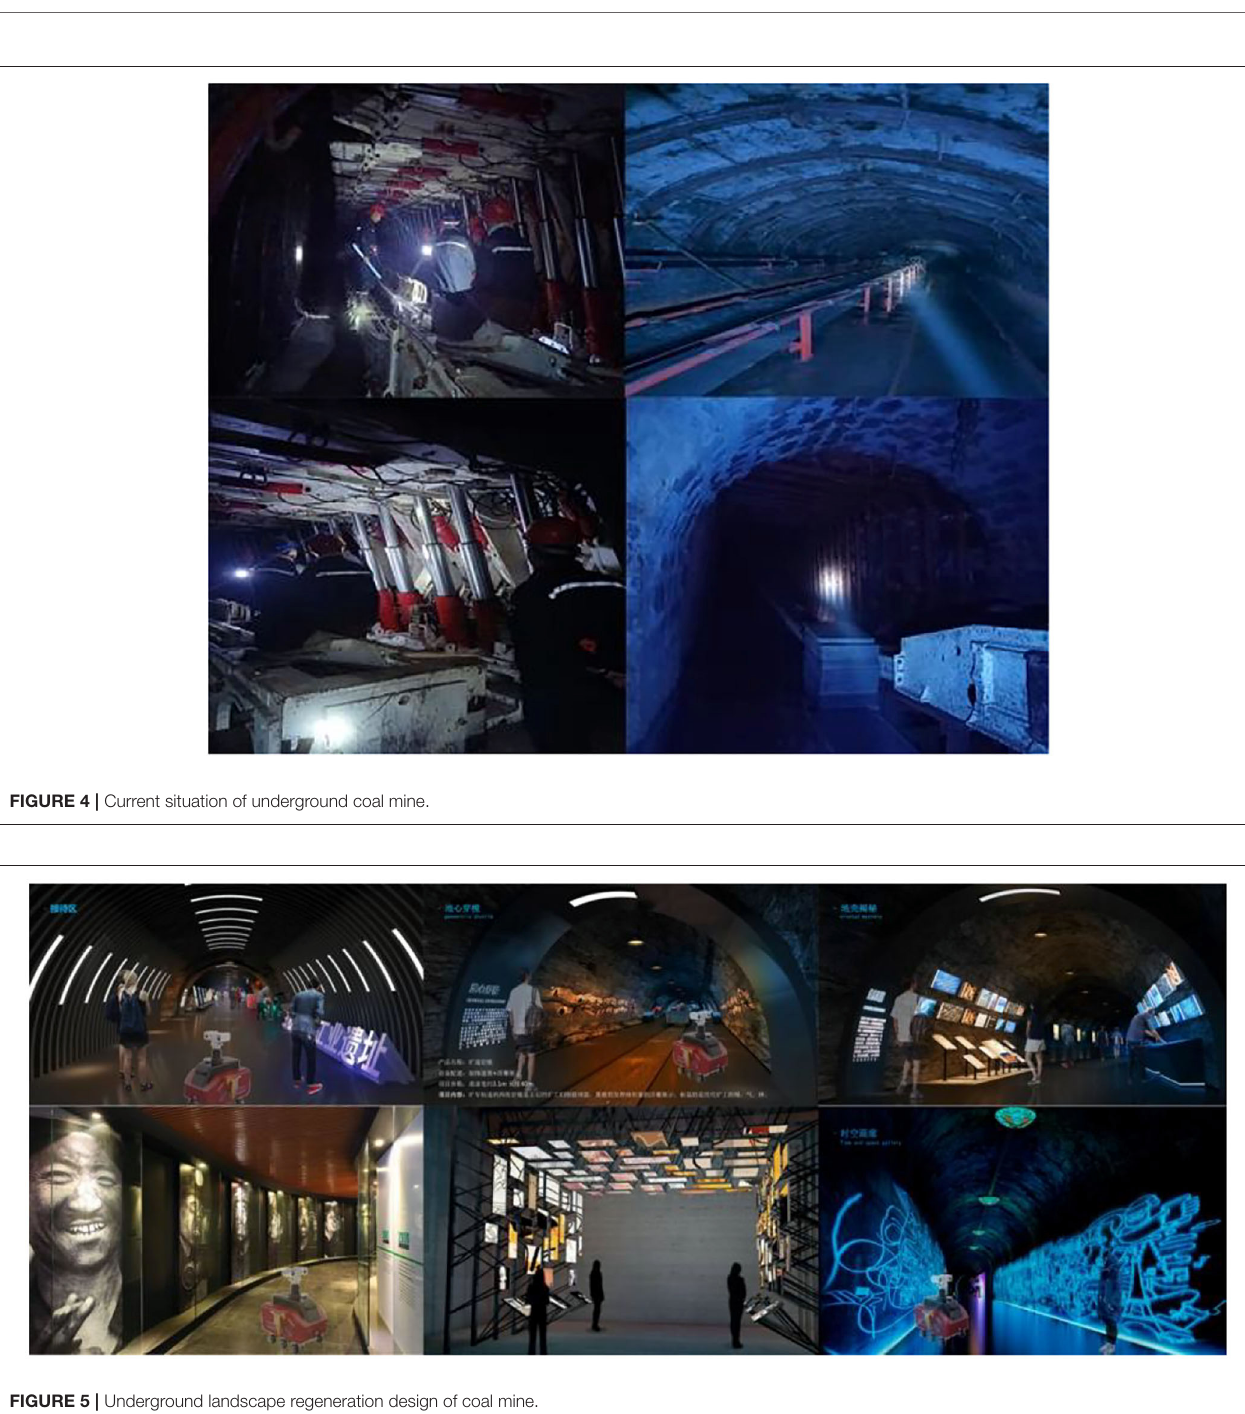
The abscissa and ordinate of the starting point in the grid map are x i and respectively. The abscissa and ordinate of the end point in the grid map are x n and y n